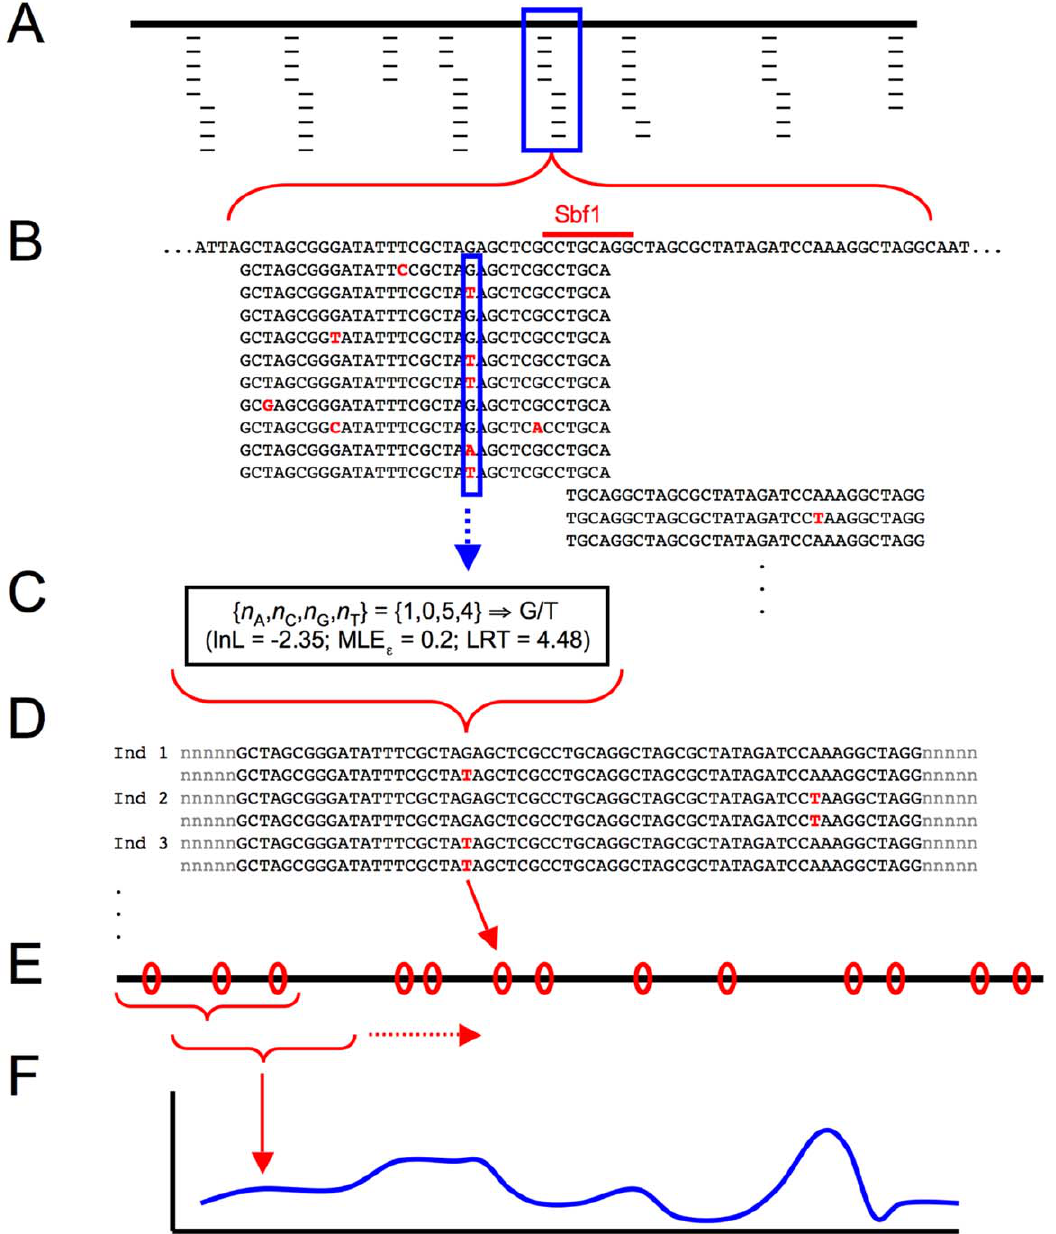
Figure 2. Schematic diagram of population genomic data analysis using RAD sequencing. (A) Following Illumina sequencing of barcoded fragments, sequence reads (thin lines) are aligned to a reference genome sequence (thick line). Depth of coverage varies across tags. Reads that do not align to the genome, or align in multiple locations, are discarded. (B) Sample of reads at a single RAD site. The recognition site for the enzyme Sbf1 is indicated along the reference genome sequence (top), and sequence reads typically proceed in both directions from this point, at which they overlap. At each nucleotide site, reads showing each of the four possible nucleotides can be tallied (solid blue box). (C) Nucleotide counts at each site for each individual are used in a maximum likelihood framework to assign the diploid genotype at the site. In this example, G/T heterozygote is the most likely genotype; the method provides the log-likelihood for this genotype, a maximum-likelihood estimate for the sequencing error rate e , and a likelihood ratio test statistic comparing G/T to the second-most-likely genotype, G/G homozygote. (D) Each individual now has a diploid genotype at each nucleotide site sequenced, and single nucleotide polymorphisms (SNPs, shown in red) can be identified across populations. Note, however, that haplotype phase is still unknown across RAD tags. (E) SNPs (red ovals) are distributed across the genome (thick line), and population genetic measures (e.g. F ST ) are calculated for each SNP. (F) A kernel smoothing average across multiple nucleotide positions is used to produce genome-wide distributions of population genetic measures. of maximum nucleotide diversity on LG III, although both p and H are moderately elevated at this region as well ( p =0.0046, p , 0.02;